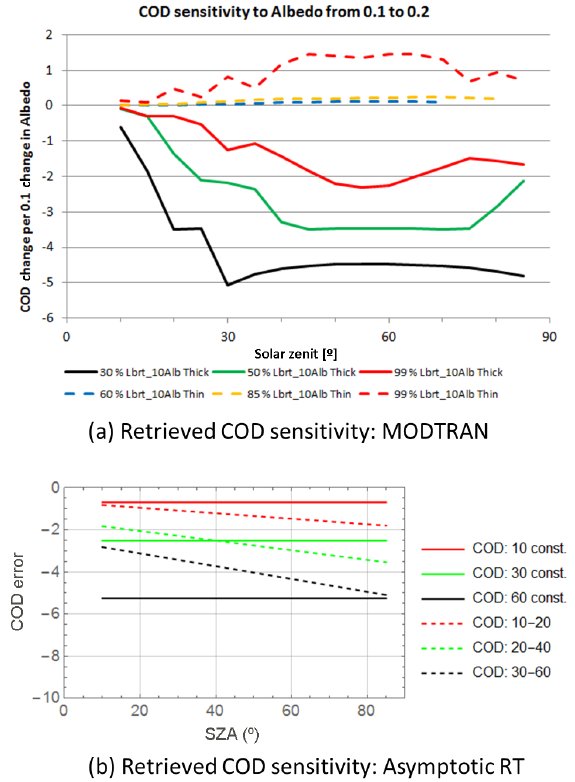
Figure 8. Retrieved COD sensitivity to change in albedo from 0.1 to 0.2 (a) for different relative cloud radiance levels as computed using MODTRAN and (b) as computed using asymptotic RT relations. See text for details.